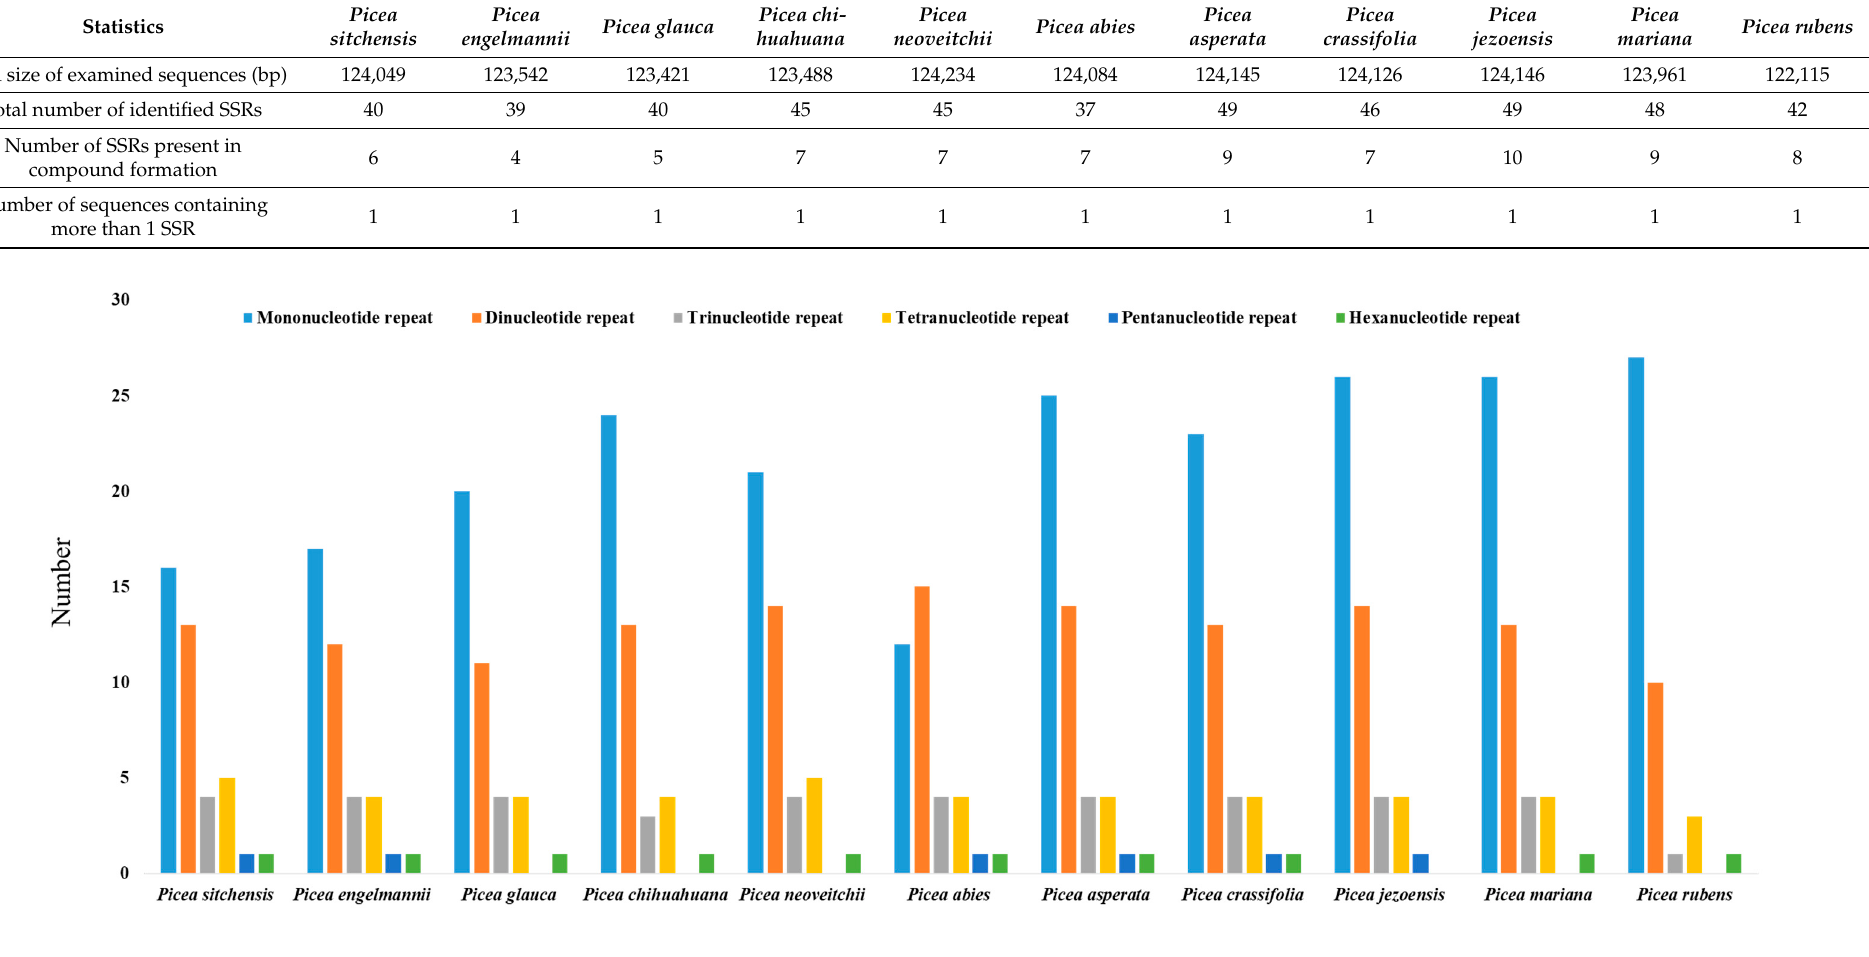
Table 5. Comparison of the SSRs identified in the chloroplast genome of P. rubens with other 10 Picea species.